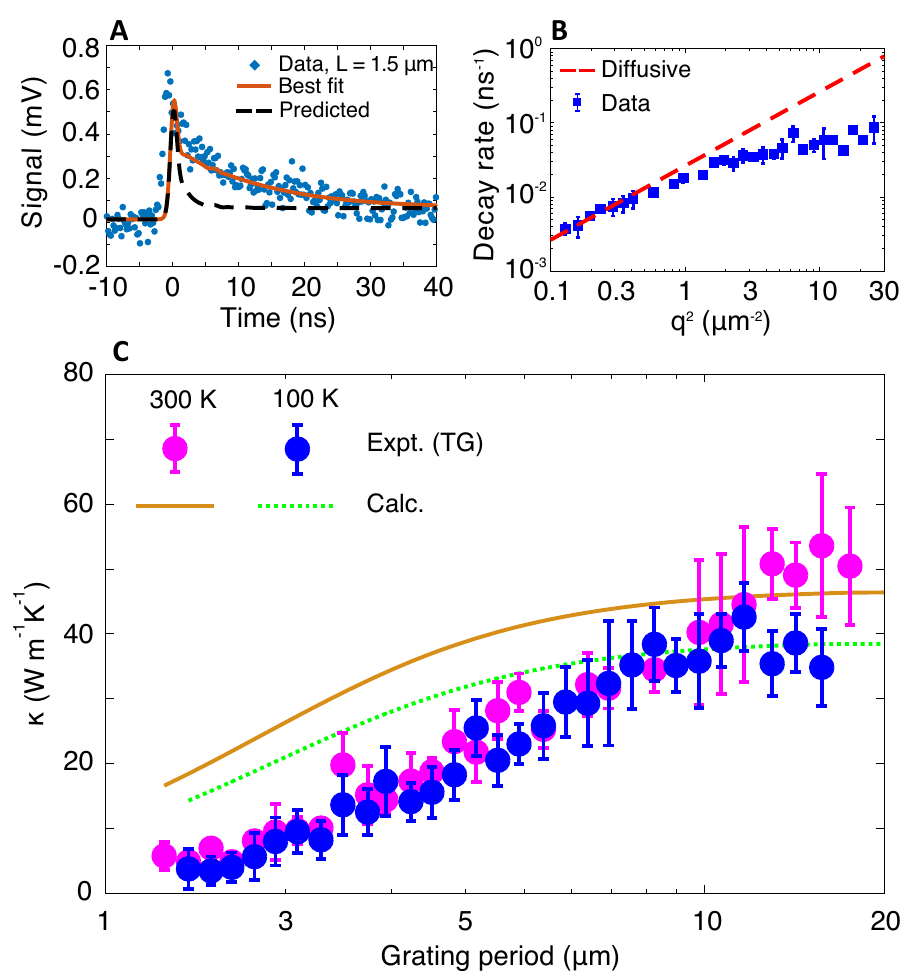
Fig. 4 Quasiballistic thermal transport in disentangled UHMWPE fi lms. A Measured TG signal versus time (symbols) for grating period L = 1.5 μ m, corresponding to q 2 ∼ 17.5 μ m − 2 , along with the best fi t (solid red line) and predicted decay estimated using the thermal conductivity obtained for L = 9.8 μ m (dashed black line). The signal is an average of 5 × 10 4 shots measured at a single location. The signal clearly decays slower than predicted based on the thermal conductivity measured at larger grating period, indicating a departure from diffusive thermal transport. B TG signal decay rate versus q 2 . The measured decay rates for q 2 ≳ 0.3 μ m − 2 deviate from that predicted from the thermal conductivity measured at L = 9.8 μ m. C Experimental thermal conductivity versus grating period at selected temperatures from experiments (magenta symbols: 300 K; blue symbols: 100 K) along with the calculation (orange solid line: 300 K; green dotted line: 100 K). The thermal conductivity exhibits a marked dependence on grating period and is nearly independent of temperature. Error bars indicate 95% con fi dence intervals obtained using the procedure given in ref. 58